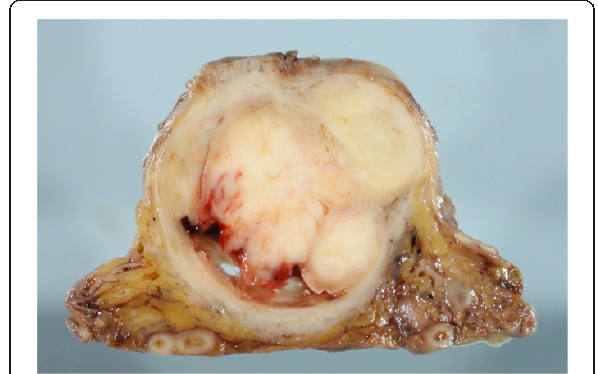
Figure 2 Cut surface of the tumor. The prostate and the bladder space are widely occupied by the tumor tissue, which exhibited a whitish-yellow multinodular appearance with focal